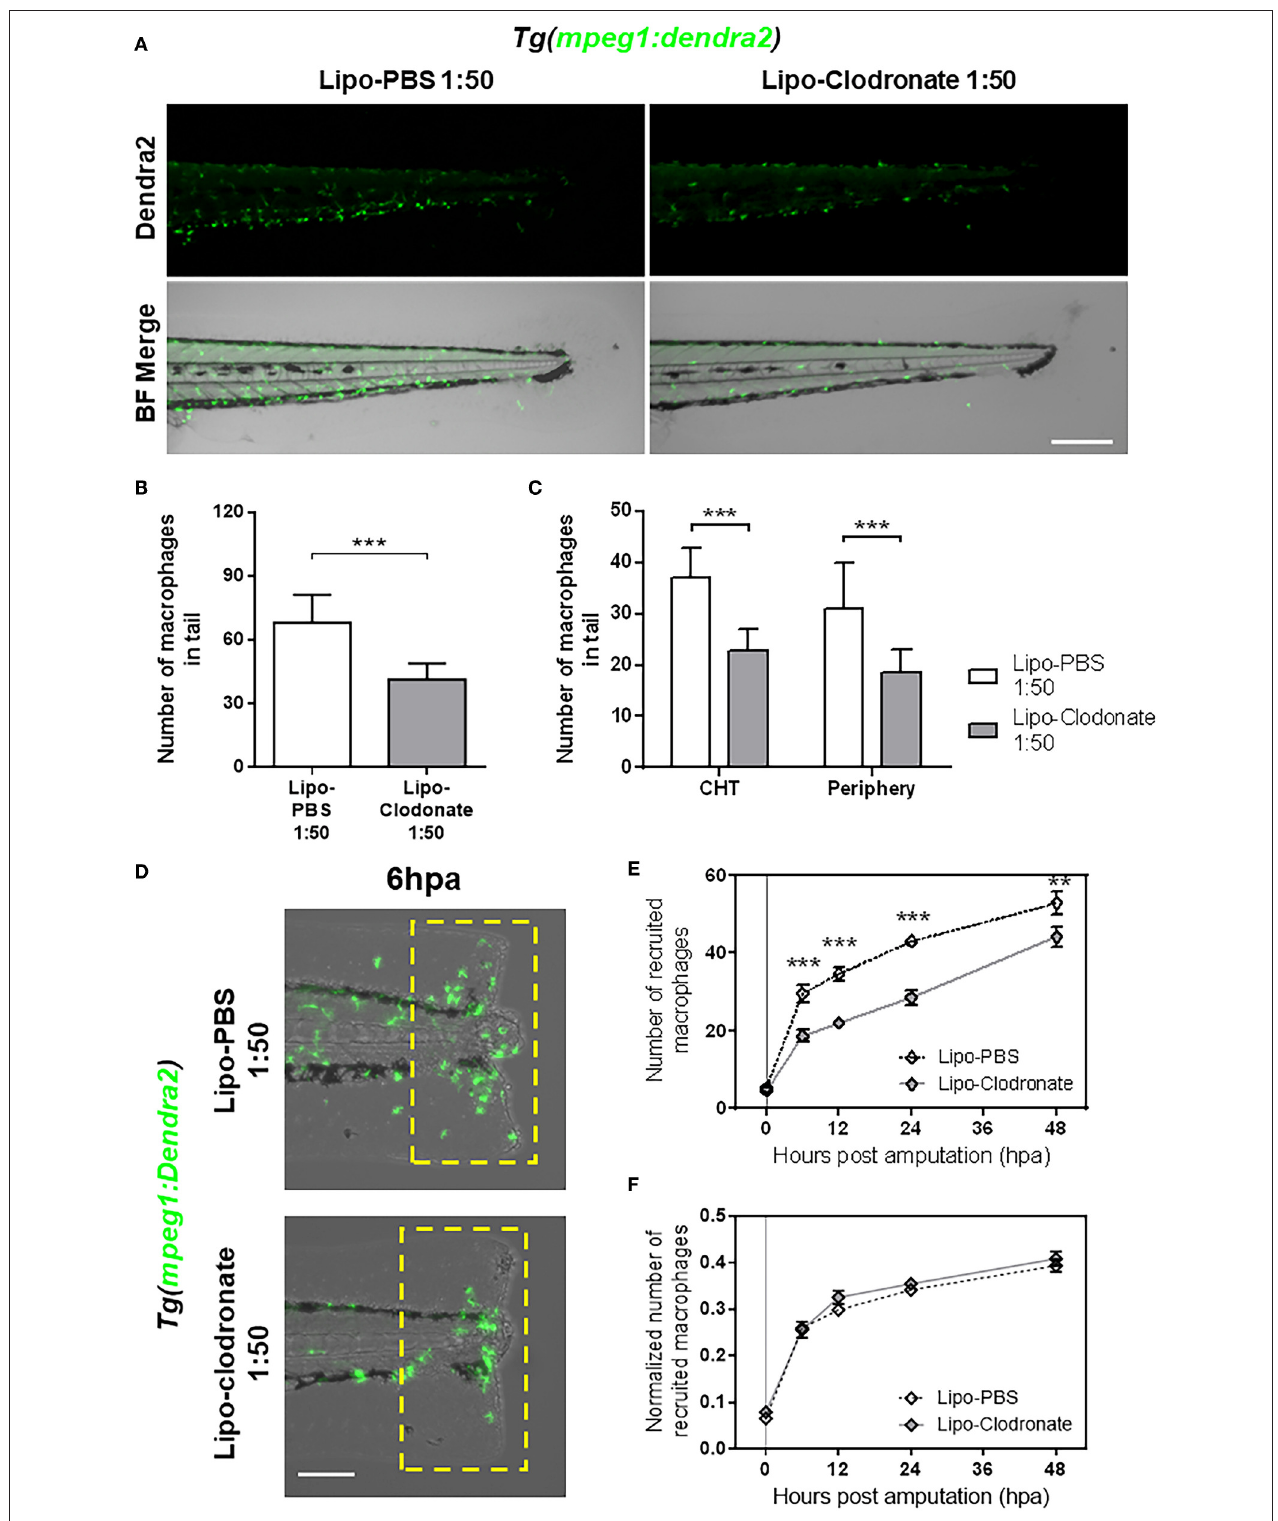
FIGURE 3 | Partial reduction of macrophages pool does not affect the kinetic of macrophage recruitment after tail fin amputation. (A) Images of 72 hpf Tg(mpeg1:Dendra2) larvae, 18h after injection of an 1:50 dilution of Lipo-PBS and Lipo-clodronate in the bloodstream, respectively. Scale bar = 250 µ m. (B) Total